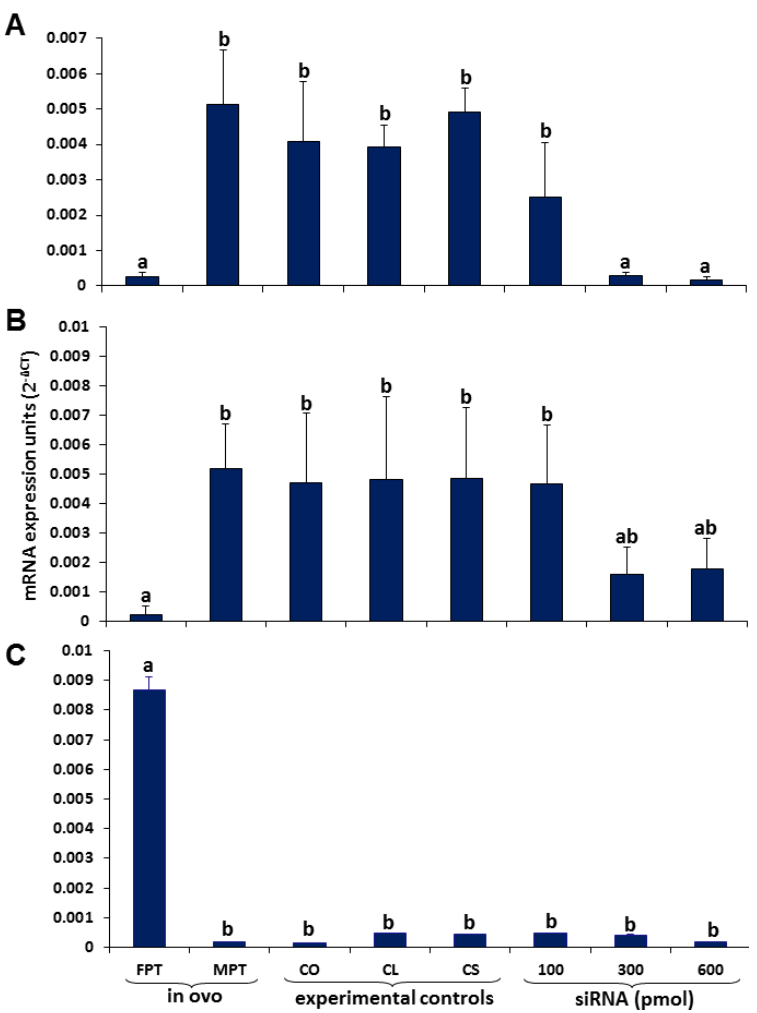
Figure 4. Relative expression of ( A ) Sox9 , ( B ) Amh and ( C ) Aromatase in L. olivacea showing a decreased expression of Sox9 and Amh in gonads transfected with 300 and 600 pmol of siRNA. Aromatase expression levels remained low in all treatments, except at FPT. Different letters indicate significant differences in expression levels. n = 3 for each